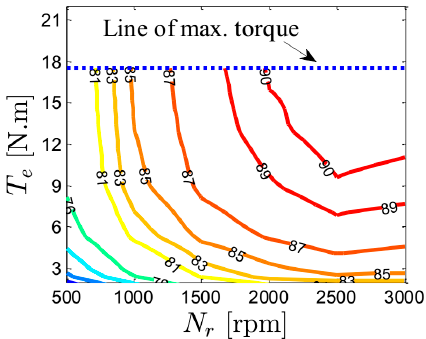
Figure 27. Measured efficiency map of the whole drive system using the S machine at optimal current angles.